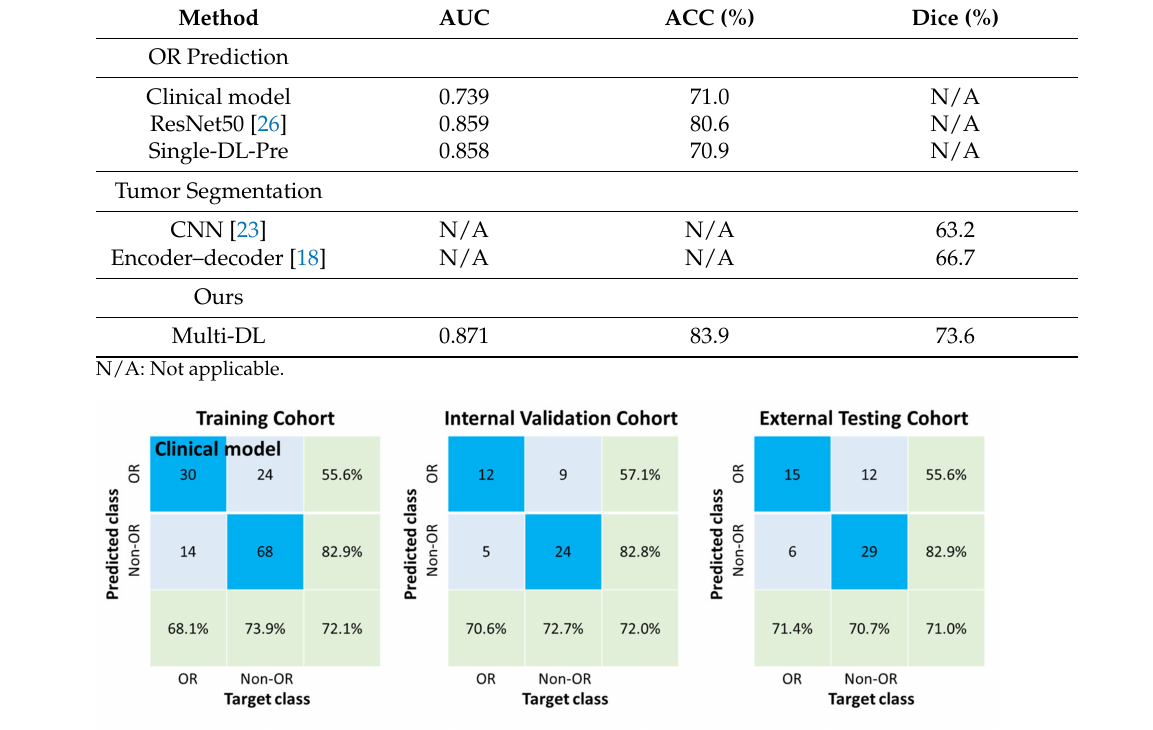
Table 4. Performance for multi-DL and compared methods.